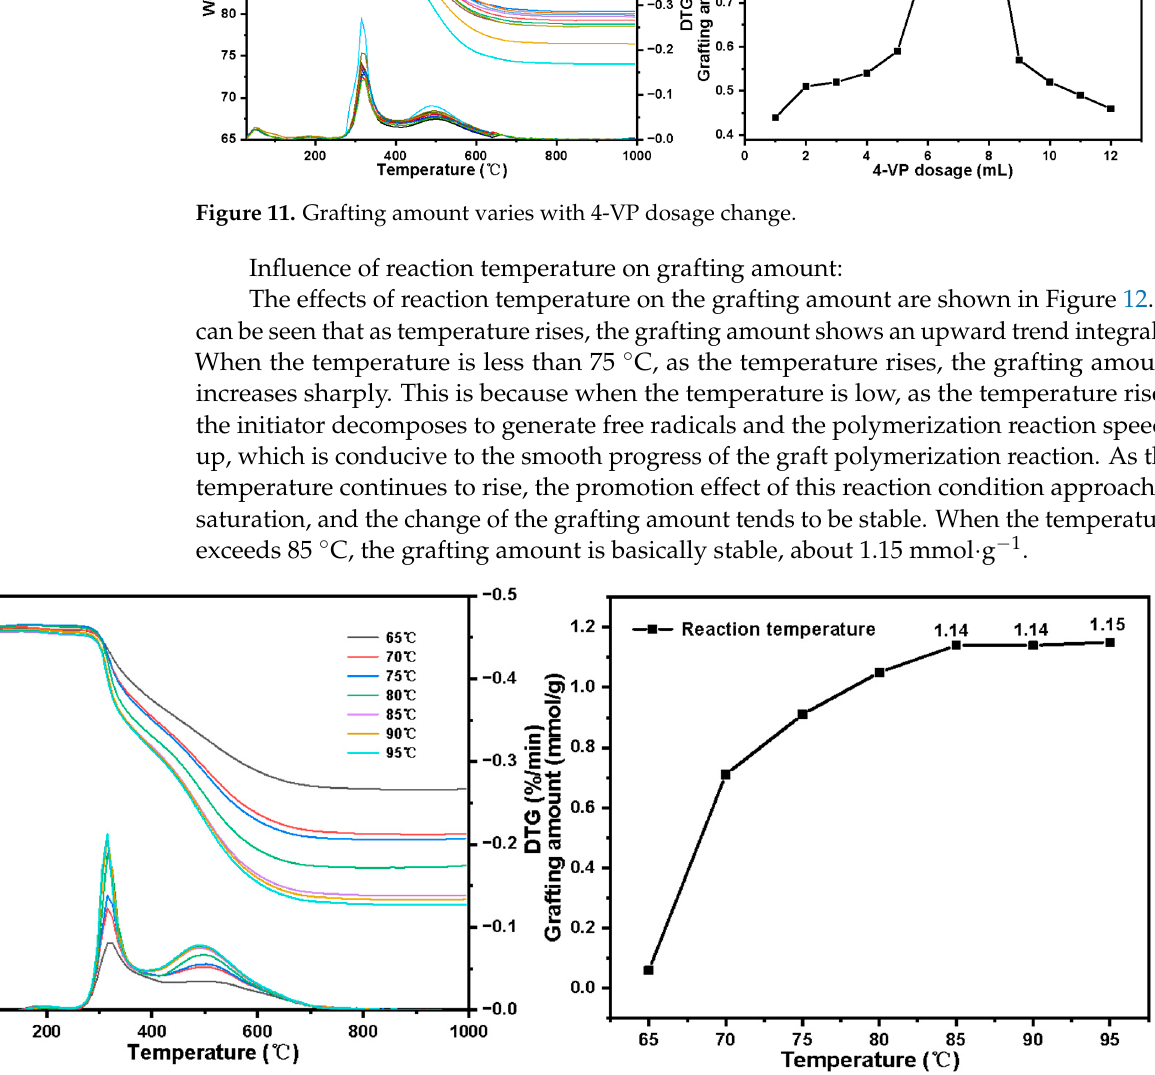
Figure 11. Grafting amount varies with 4-VP dosage change.